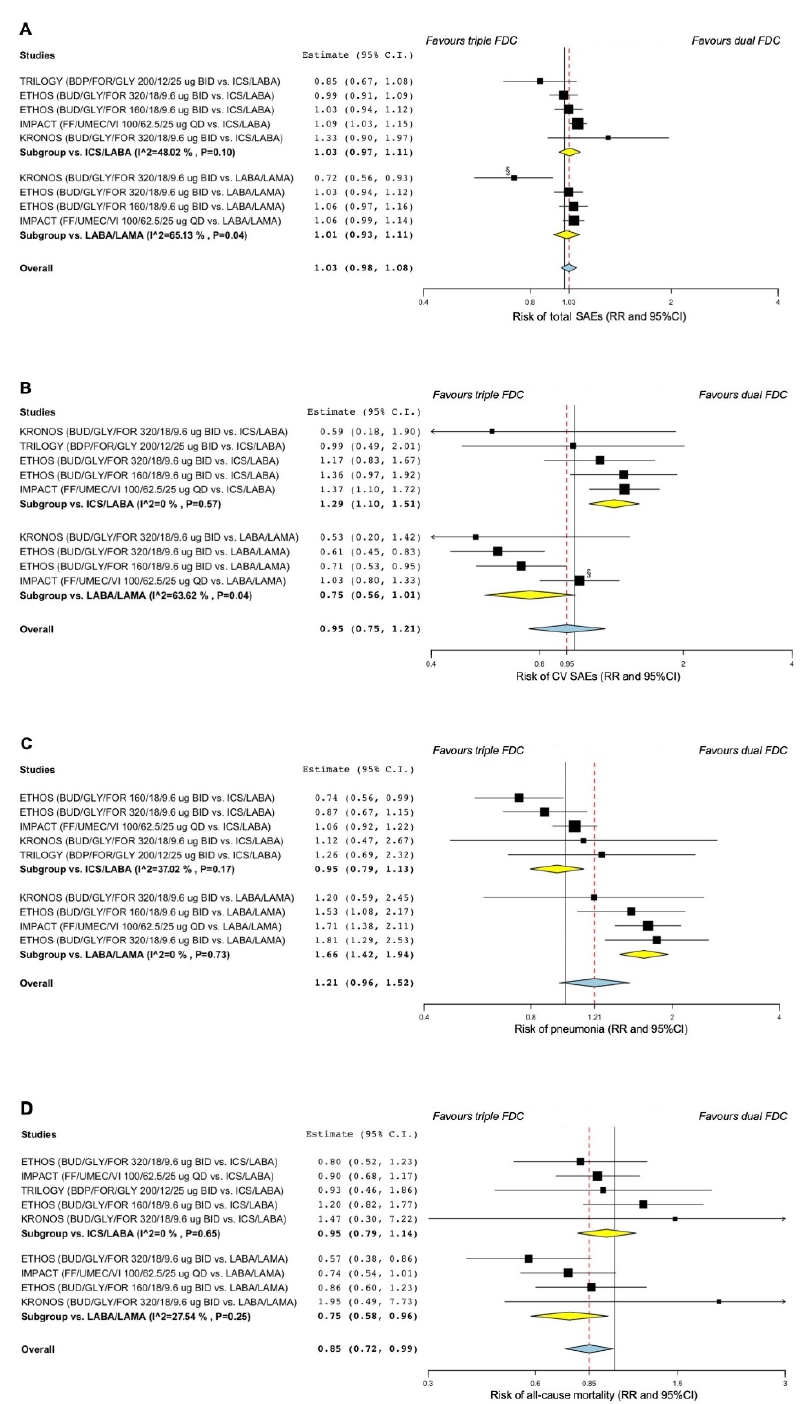
Figure 3. Forest plots of pairwise meta-analysis concerning the safety of triple ICS/LABA/LAMA FDCs vs. dual FDCs on the risk of total SAEs ( A ), CV SAEs ( B ), pneumonia ( C ), and all-cause mortality ( D ). § Treatment comparison introducing substantial heterogeneity in the pairwise meta-analysis. BDP: beclomethasone dipropionate; BID: bis in die, twice daily; BUD: budesonide; CV: cardiovascular; FDC: fixed-dose combination; FF: fluticasone furoate; FOR: formoterol fumarate; GLY: glycopyrronium bromide or glycopyrrolate; ICS: inhaled corticosteroid; LABA: long-acting β 2 -adrenoceptor agonist; LAMA: long-acting muscarinic antagonist; QD: quaque die, once daily; RR: relative risk; SAE: serious adverse event; UMEC: umeclidinium bromide; VI: vilanterol.